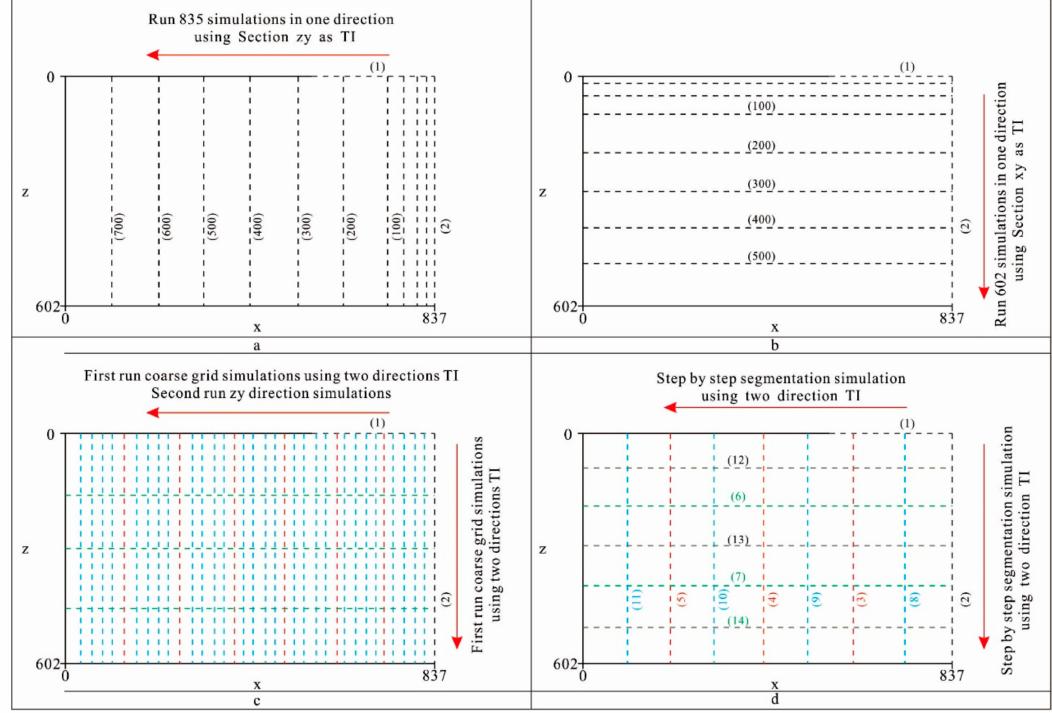
Figure 9. Four types of sequences of simulation surface. ( a , b ) use a unidirectional training image; ( c , d ) use bidirectional training